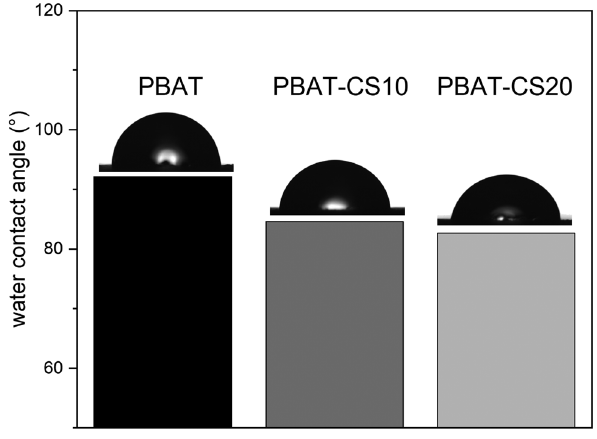
Figure 4: Water contact angle of PBAT, PBAT - CS10, and PBAT